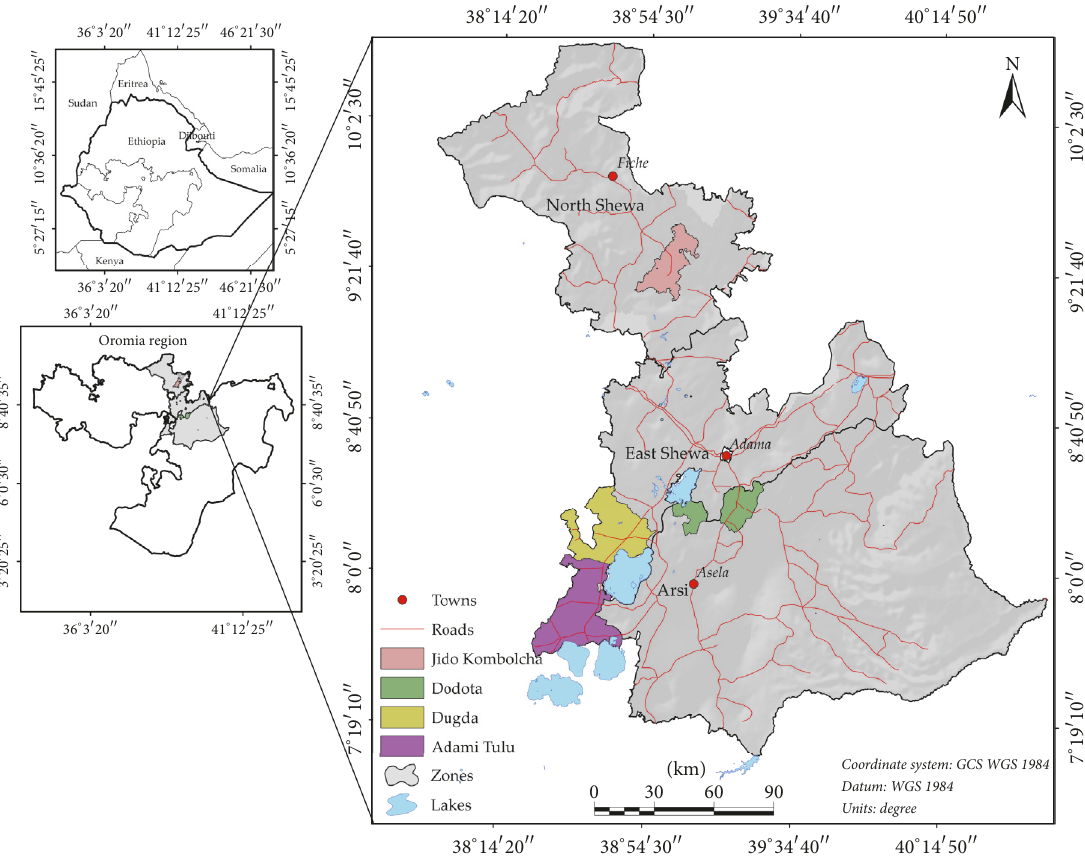
Figure 1: Map of study